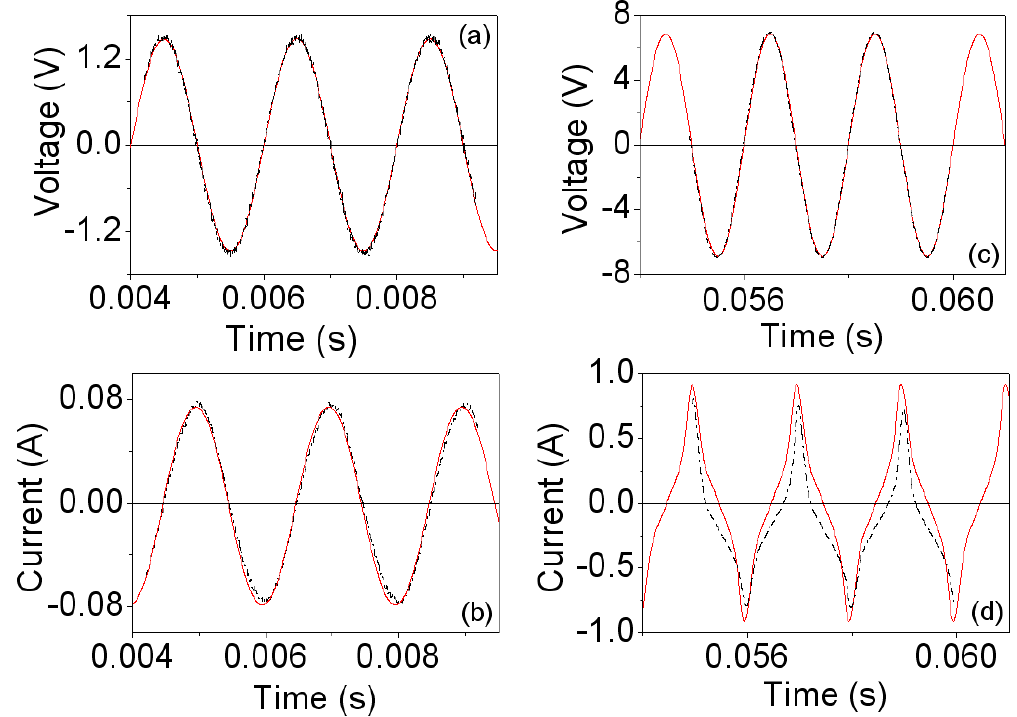
≈ 7.5 V and time step τ = 10 −4 p